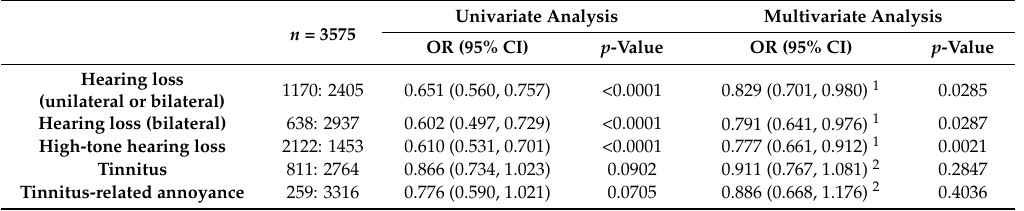
Table 2. Odds ratios (OR) and 95% confidence intervals (CI) for hearing loss and tinnitus according to chocolate consumption.